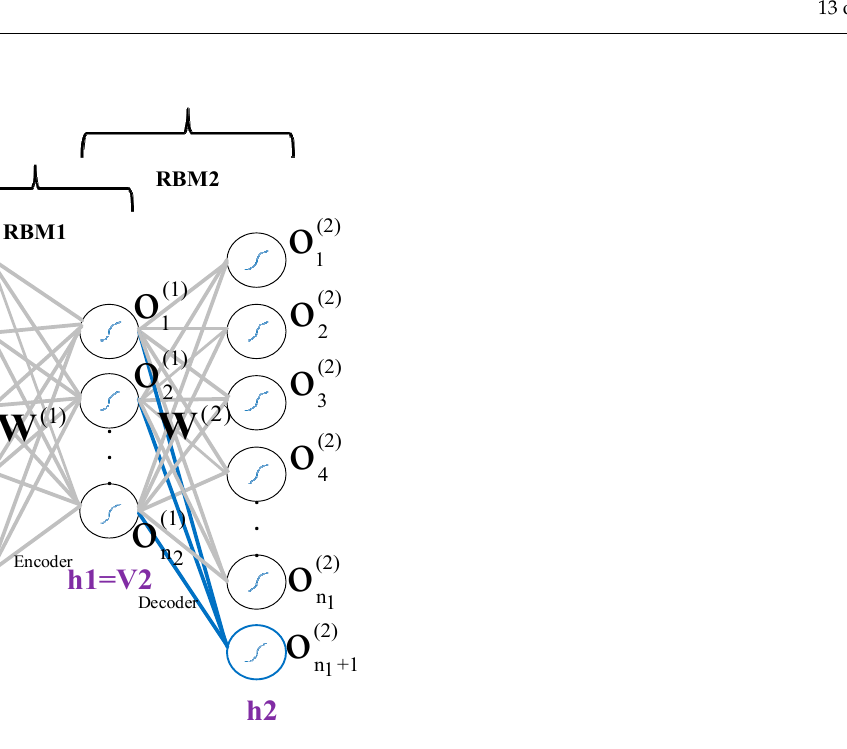
Figure 4. Converting auto-encoder to two RBMs for tuning the initial weights of the encoder and decoder layers.